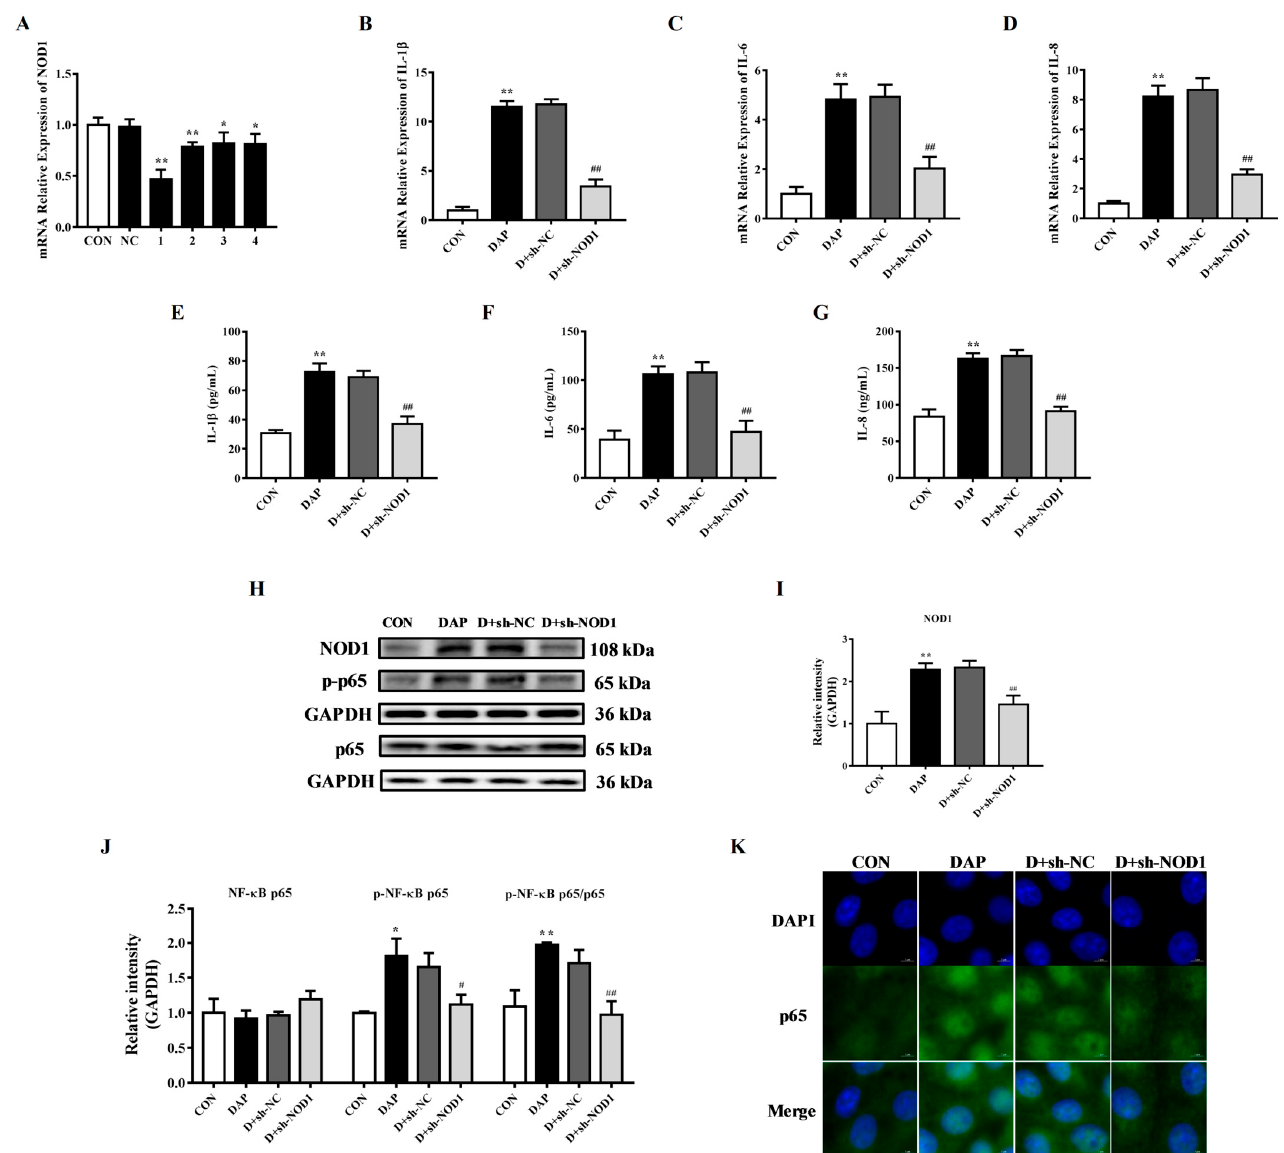
Figure 6. Effects of sh-NOD1 on the inflammatory response induced by iE-DAP in BMECs. ( A ) The gene expression of NOD1 in BEMCs after transfection with NOD1-specific shRNA. ( B – D ) Gene expression of inflammatory cytokines in BMECs treated with 1000 ng/mL iE-DAP for 12 h after sh-NOD1 transfection for 36 h. ( E – G ) The concentration of inflammatory cytokines in culture supernatant of BMECs treated with iE-DAP after sh-NOD1 transfection. ( H – J ) WB representative bands and quantitative results of NOD1/NF- κ B signaling pathway-related proteins and ( K ) immunofluorescence results of NF- κ B p65 in BMECs treated with iE-DAP after sh-NOD1 transfection. In the immunofluorescence results, the scale bar = 5 µ m. Results are reported as the mean ± SEM. * p < 0.05, ** p < 0.01, represent a significant difference compared with the control group. # p < 0.05, ## p < 0.01, represent a significant difference compared with the iE-DAP group. D + sh-NC: sh-NC + iE-DAP group; D + sh-NOD1: sh-NOD1 + iE-DAP